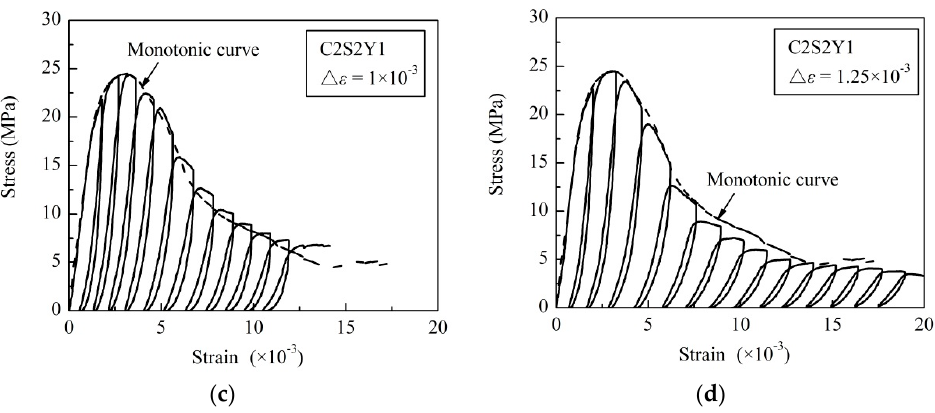
Figure 4. Cyclic stress–strain curves for: ( a ) unconfined concrete specimen (C2S0Y0) Δε = 5.0 × 10 − 4 ; ( b ) unconfined concrete specimen (C2S0Y0) Δε = 7.5 × 10 − 4 ; ( c ) stirrup-confined concrete specimen (C2S2Y1) Δε = 1.00 × 10 − 3 ; and ( d ) stirrup-confined concrete specimen (C2S2Y1) Δε = 1.25 × 10 − 3 .